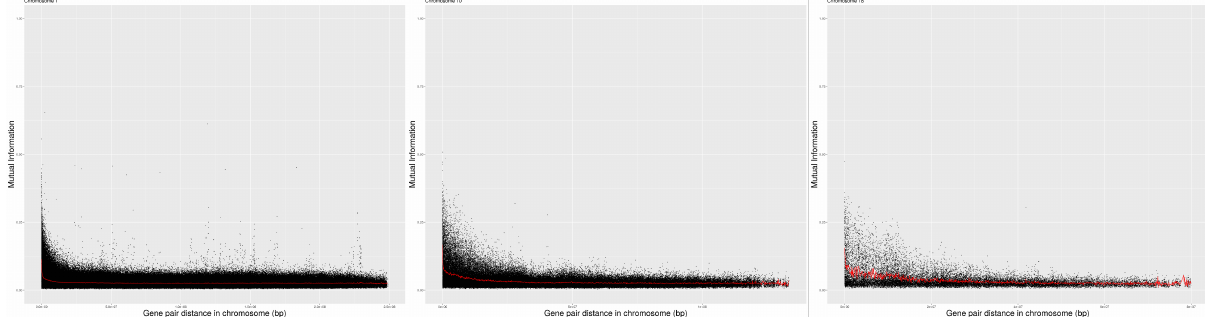
Fig. 1 Gene–gene mutual information–distance distributions. Depicted are chromosomes 1, 10, and 18 (large, medium, and small